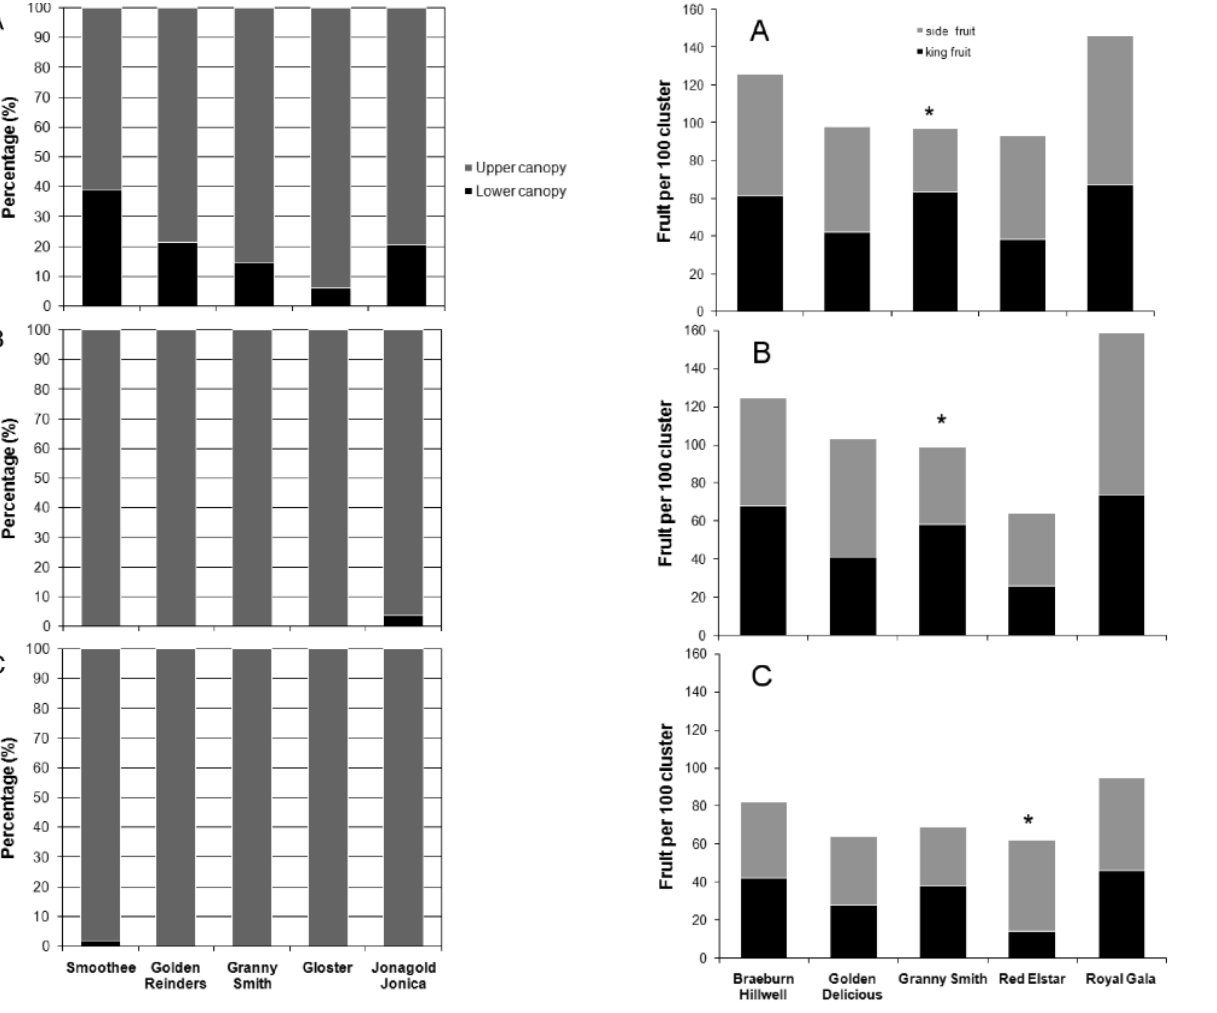
Fig. 3. The share of sunburned fruit located in the upper or lower canopy on M.9 (A), MM.106 (B) and seedling (C) rootstock. The ratio of sunburned fruit was significantly greater for the upper canopy at P < 0.05 level. Data are based on the average of 2006 and 2007.